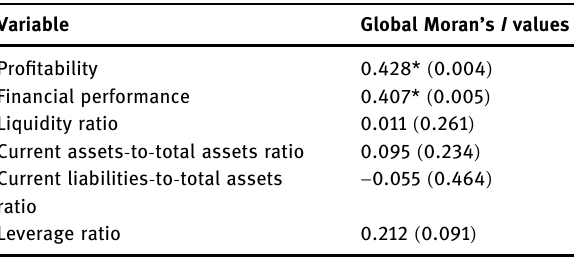
Table 6: Global Moran ’ s I values for the several dependent and independent variables considered in this study, across the 28 former European Union countries on average over the